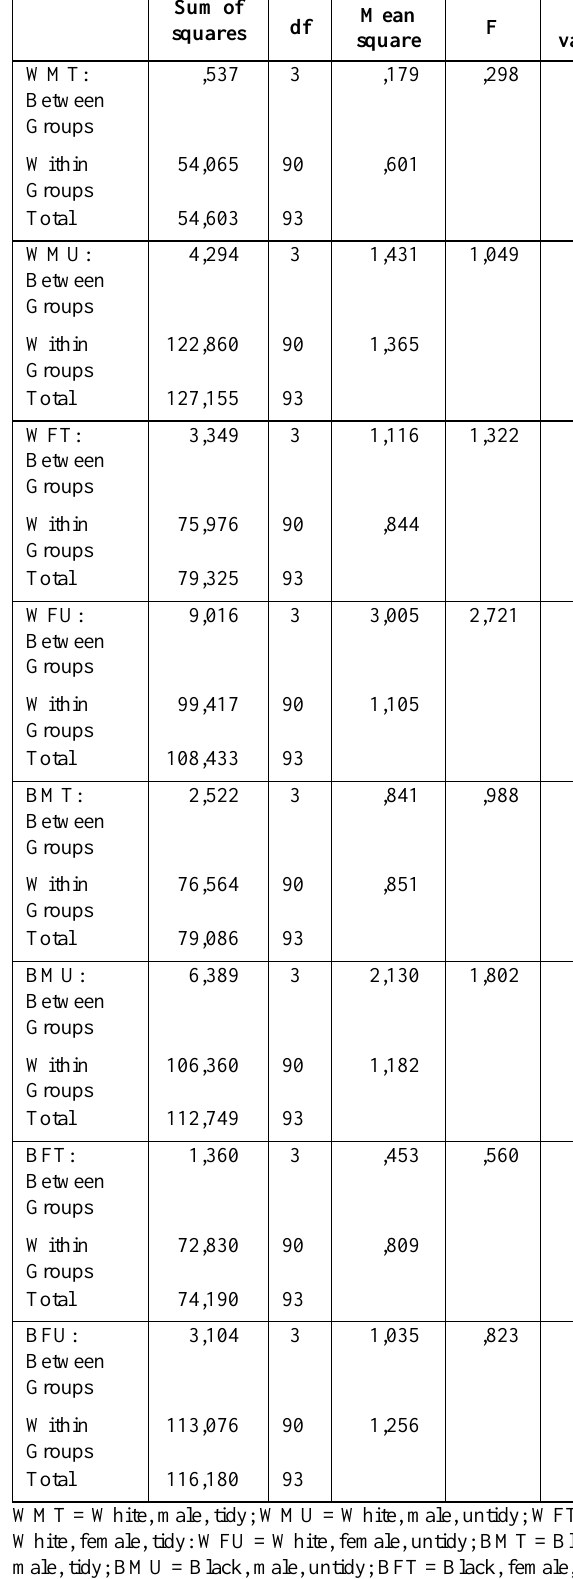
Table 7: ANOVA results: Two-way interactions between gender and neatness